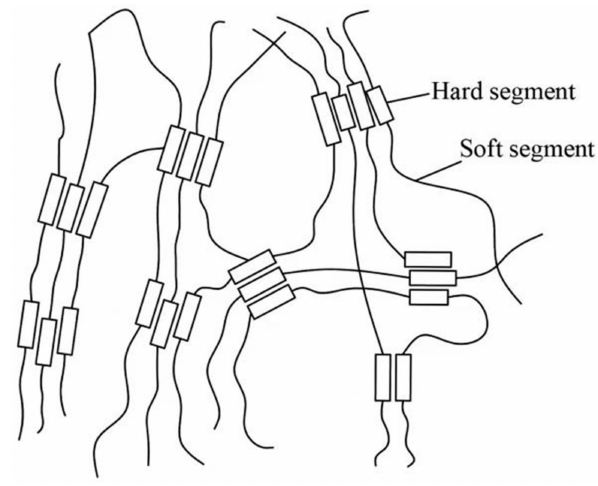
Figure 6. PU soft and hard segment structure